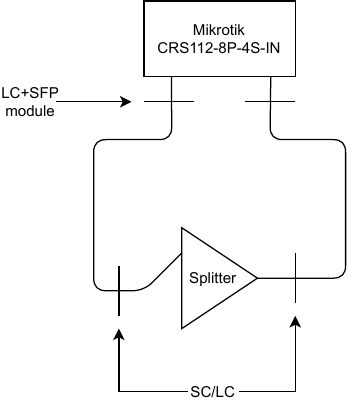
Figure 3. P2P—time of attack measurement